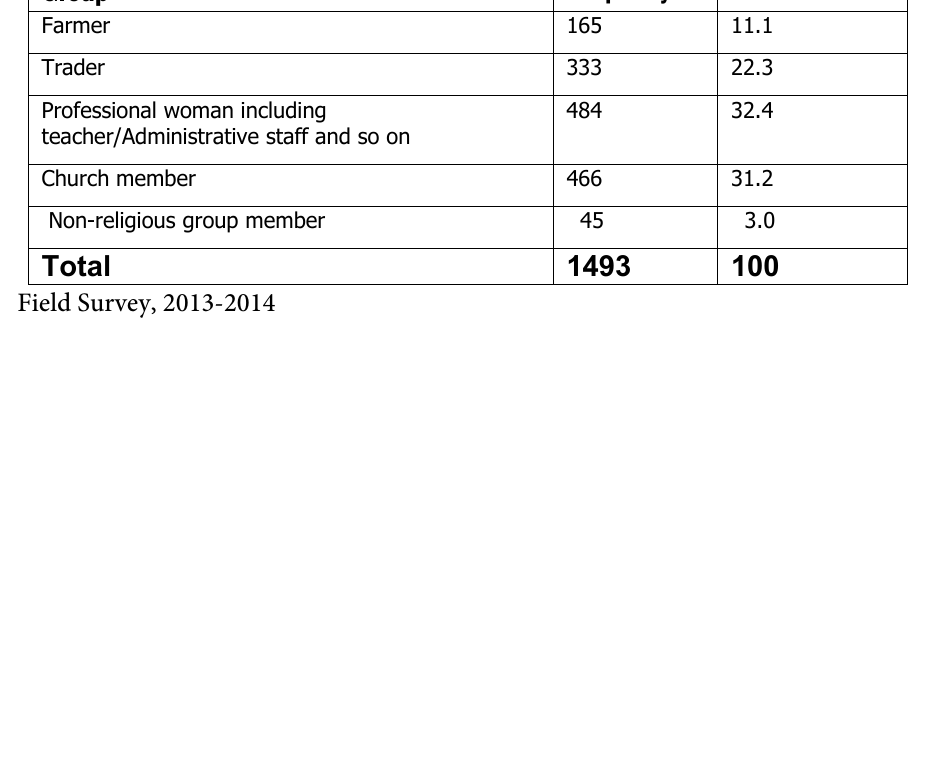
Table 4: Group Affiliations of the Respondents